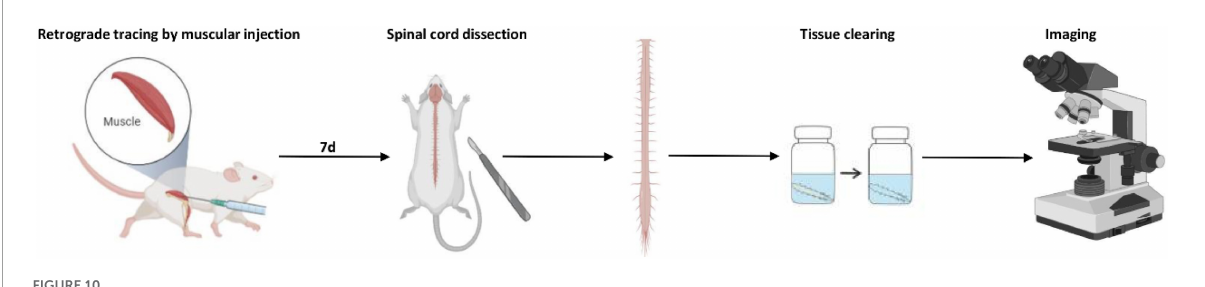
FIGURE10 The schematic process of 3D imaging for the spinal